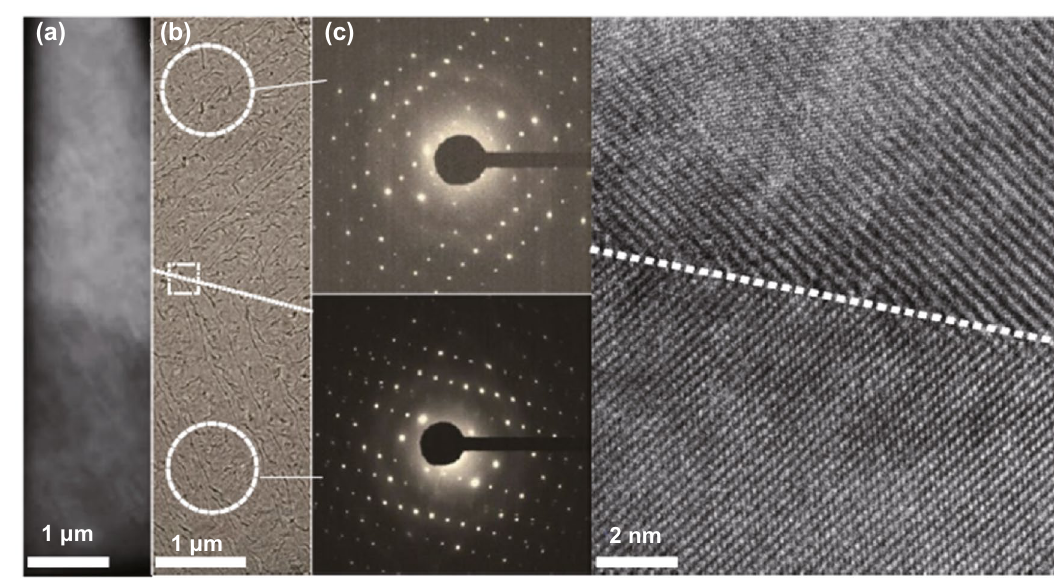
Fig. 6 a Optical image of the synthesized Te nanoflakes. b , c TEM and HRTEM images of the Te nanoflakes present in a . Adapted with permis‑ sion from [80]. Copyright 2020, Nature publishing Group